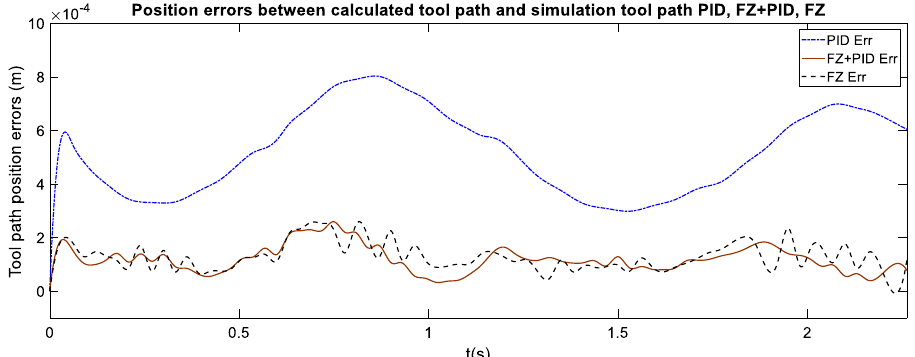
Figure 19. Tool path position errors between desired value and simulation result in normal cutting force mode.